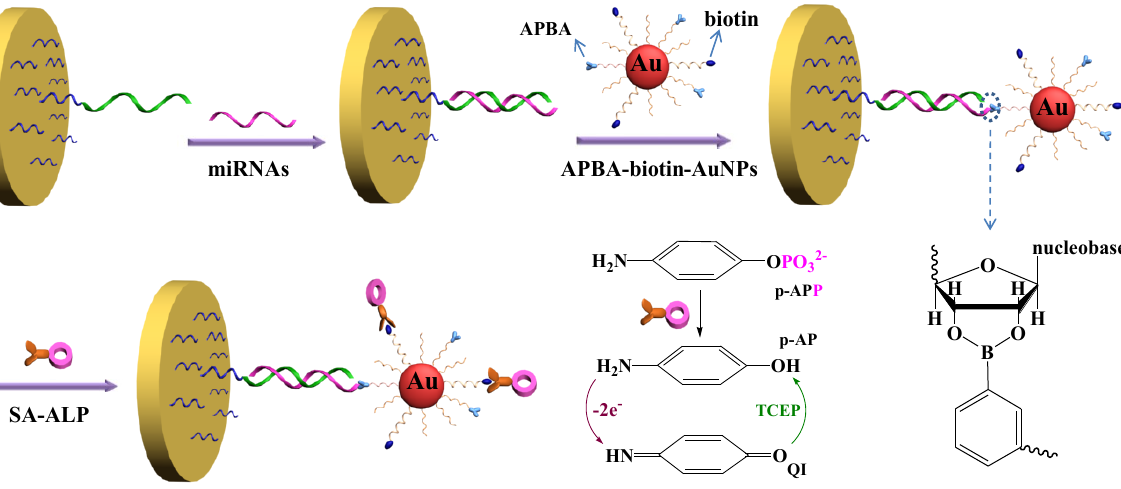
Figure 4. Schematic representation of the label-free detection of miRNAs based on the triple signal amplification of APBA-biotin-AuNPs, SA-ALP and the p -AP redox-cycling reaction. Reprinted with permission from [48]. Copyright 2014